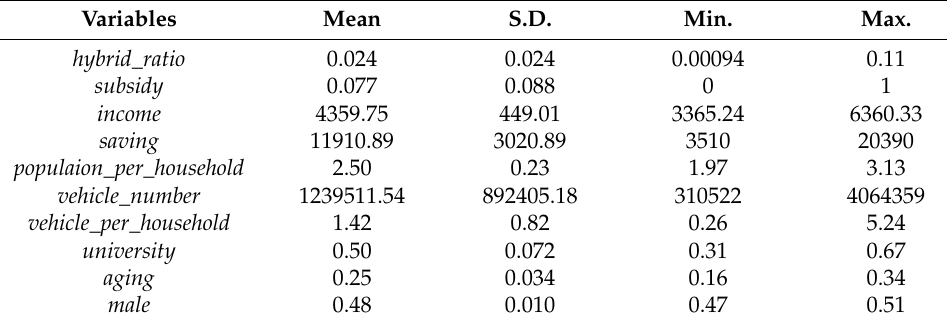
Table 2. Descriptive statistics of the variables for the whole